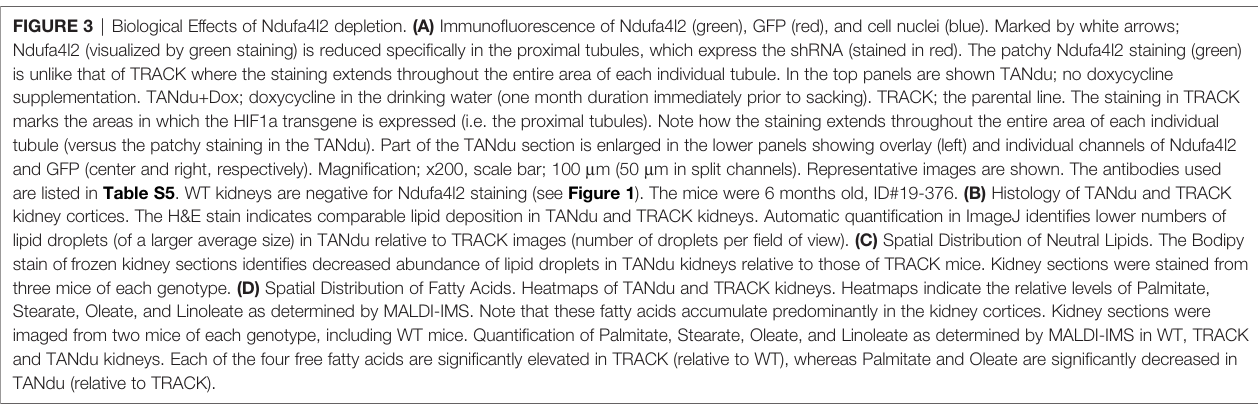
FIGURE 3 | Biological Effects of Ndufa4l2 depletion. (A) Immuno fl uorescence of Ndufa4l2 (green), GFP (red), and cell nuclei (blue). Marked by white arrows; Ndufa4l2 (visualized by green staining) is reduced speci fi cally in the proximal tubules, which express the shRNA (stained in red). The patchy Ndufa4l2 staining (green) is unlike that of TRACK where the staining extends throughout the entire area of each individual tubule. In the top panels are shown TANdu; no doxycycline supplementation. TANdu+Dox; doxycycline in the drinking water (one month duration immediately prior to sacking). TRACK; the parental line. The staining in TRACK marks the areas in which the HIF1a transgene is expressed (i.e. the proximal tubules). Note how the staining extends throughout the entire area of each individual tubule (versus the patchy staining in the TANdu). Part of the TANdu section is enlarged in the lower panels showing overlay (left) and individual channels of Ndufa4l2 and GFP (center and right, respectively). Magni fi cation; x200, scale bar; 100 m m (50 m m in split channels). Representative images are shown. The antibodies used are listed in Table S5 . WT kidneys are negative for Ndufa4l2 staining (see Figure 1 ). The mice were 6 months old, ID#19-376. (B) Histology of TANdu and TRACK kidney cortices. The H&E stain indicates comparable lipid deposition in TANdu and TRACK kidneys. Automatic quanti fi cation in ImageJ identi fi es lower numbers of lipid droplets (of a larger average size) in TANdu relative to TRACK images (number of droplets per fi eld of view). (C) Spatial Distribution of Neutral Lipids. The Bodipy stain of frozen kidney sections identi fi es decreased abundance of lipid droplets in TANdu kidneys relative to those of TRACK mice. Kidney sections were stained from three mice of each genotype. (D) Spatial Distribution of Fatty Acids. Heatmaps of TANdu and TRACK kidneys. Heatmaps indicate the relative levels of Palmitate, Stearate, Oleate, and Linoleate as determined by MALDI-IMS. Note that these fatty acids accumulate predominantly in the kidney cortices. Kidney sections were imaged from two mice of each genotype, including WT mice. Quanti fi cation of Palmitate, Stearate, Oleate, and Linoleate as determined by MALDI-IMS in WT, TRACK and TANdu kidneys. Each of the four free fatty acids are signi fi cantly elevated in TRACK (relative to WT), whereas Palmitate and Oleate are signi fi cantly decreased in TANdu (relative